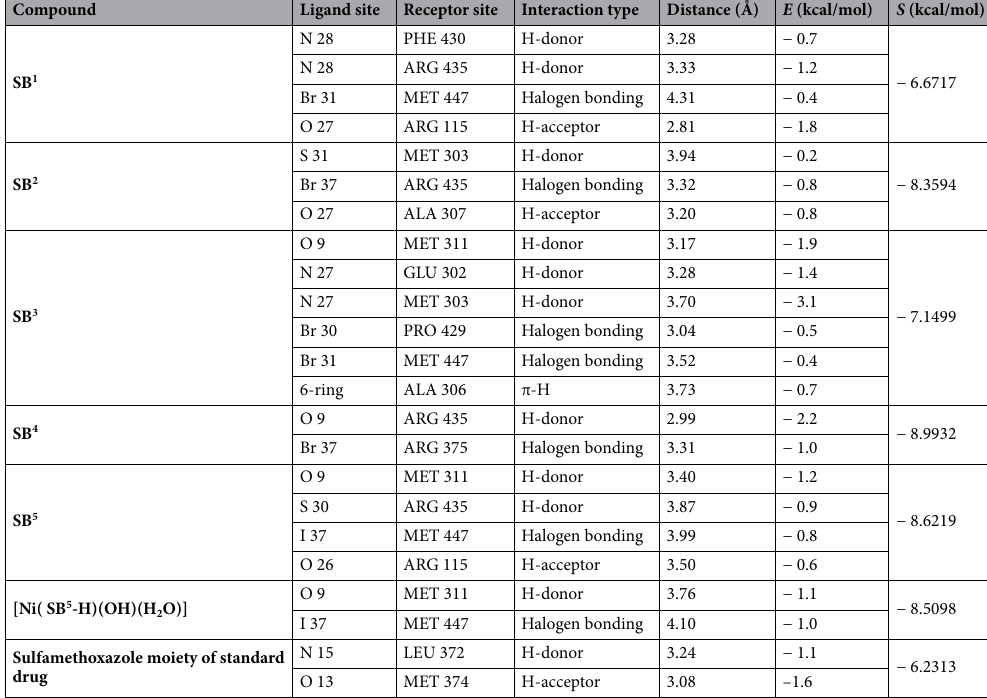
Table 4. The interaction parameters of the synthesized compounds versus 3s7s protein.